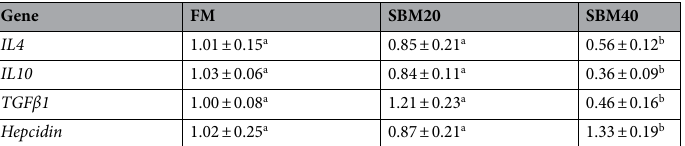
Table 4. Effect of SBM protein substitute for fish meal protein on the pro-inflammatory-related gene expression in DI tissues of pearl gentian grouper (n = 3).